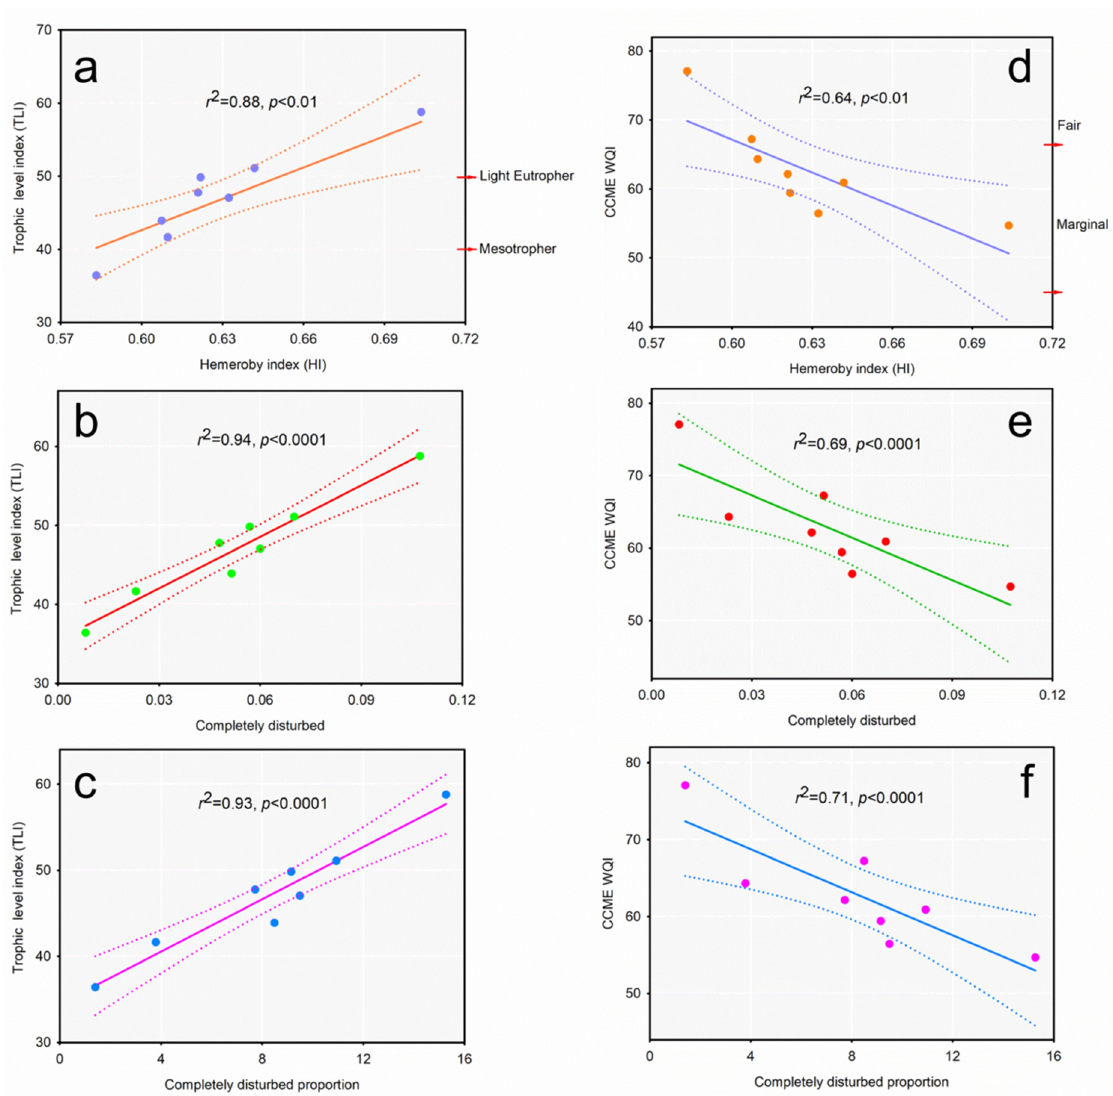
Figure 6. Correlations between anthropogenic interference and rivers’ environment quality in Shanxi Province. The confidence interval of regression model is 95%. p < 0.01 indicates the regression coefficient has a significant level. ( a ) Correlations between TLI and Hemoroby index; ( b ) correlations between TLI and Completely disturbed; ( c ) correlations between TLI and Completely disturbed proportion; ( d ) correlations between CCME WQI and Hemoroby index; ( e ) correlations between CCME WQI and Completely disturbed; ( f ) correlations between CCME WQI and completely disturbed proportion; 30 ≤ TLI ≤ 50 indicates mesotropher; 50 < TLI ≤ 60 indicates light